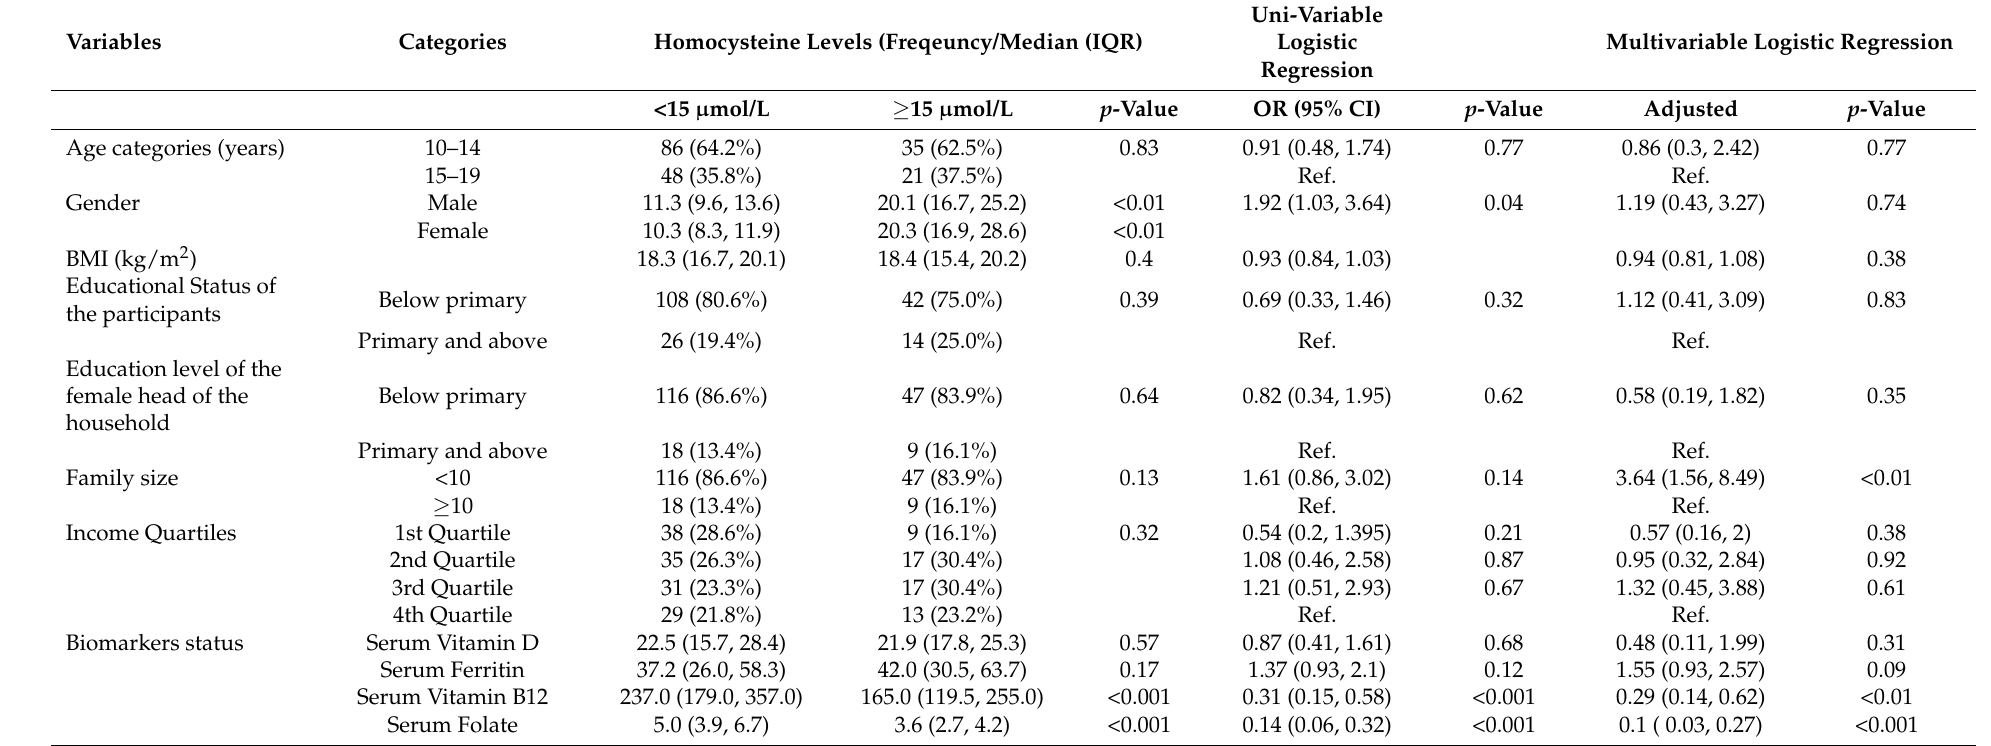
Table 3. Univariate and multivariate analysis of risk factors and biomarkers for